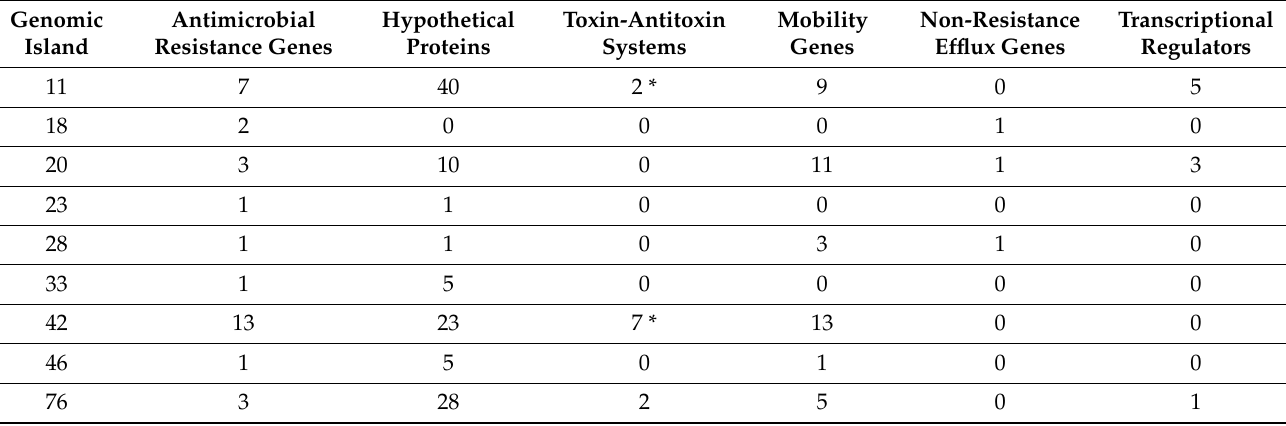
Table 1. Summary of the properties of resistance islands of Serratia sp. HRI, including a selection of genes within the resistance islands identified by IslandViewer4.